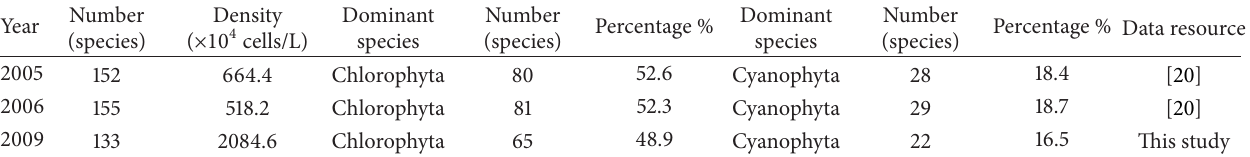
Table 1: Variations of phytoplankton density and dominant species.